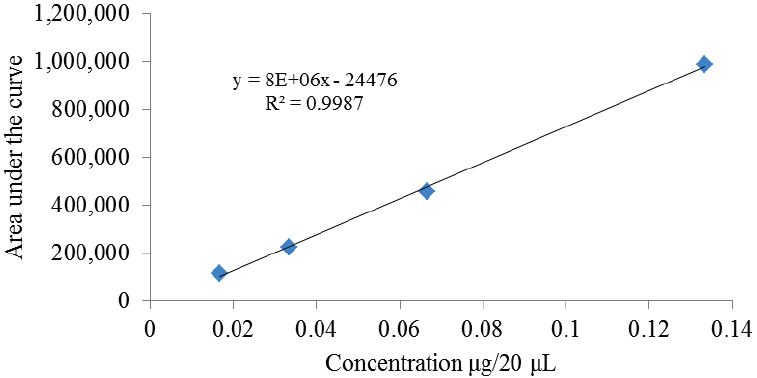
Figure 3. Densitogram obtained during quercetin